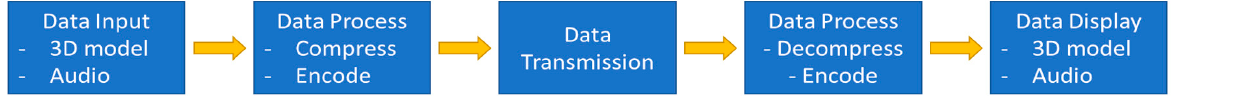
Figure 5. The data transmission over the network for the telepresence system.